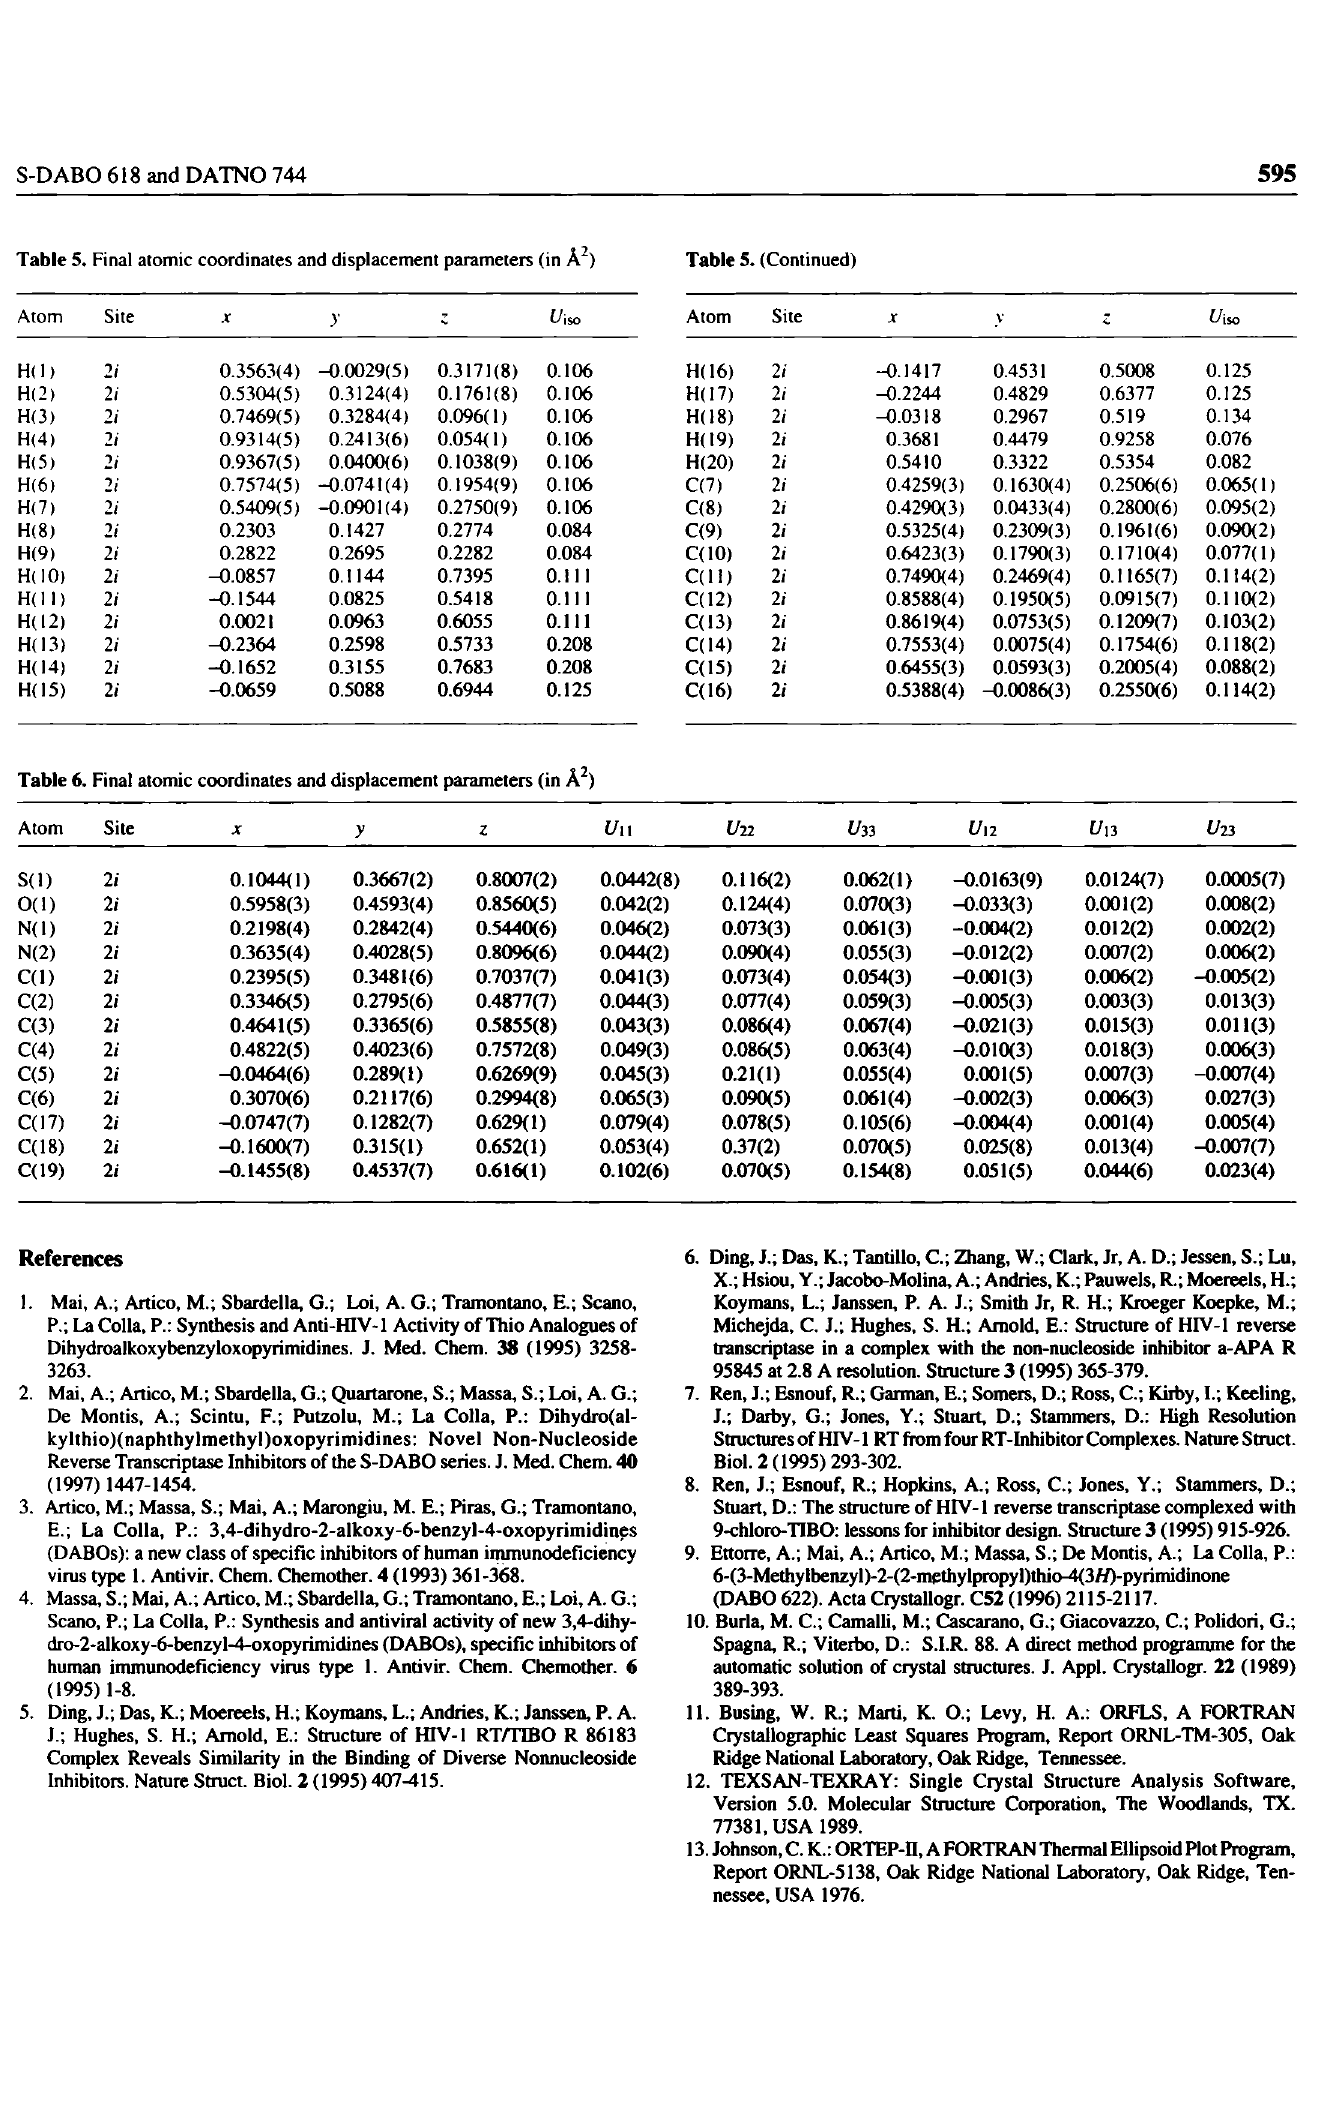
Table 6. Final atomic coordinates and displacement parameters (in